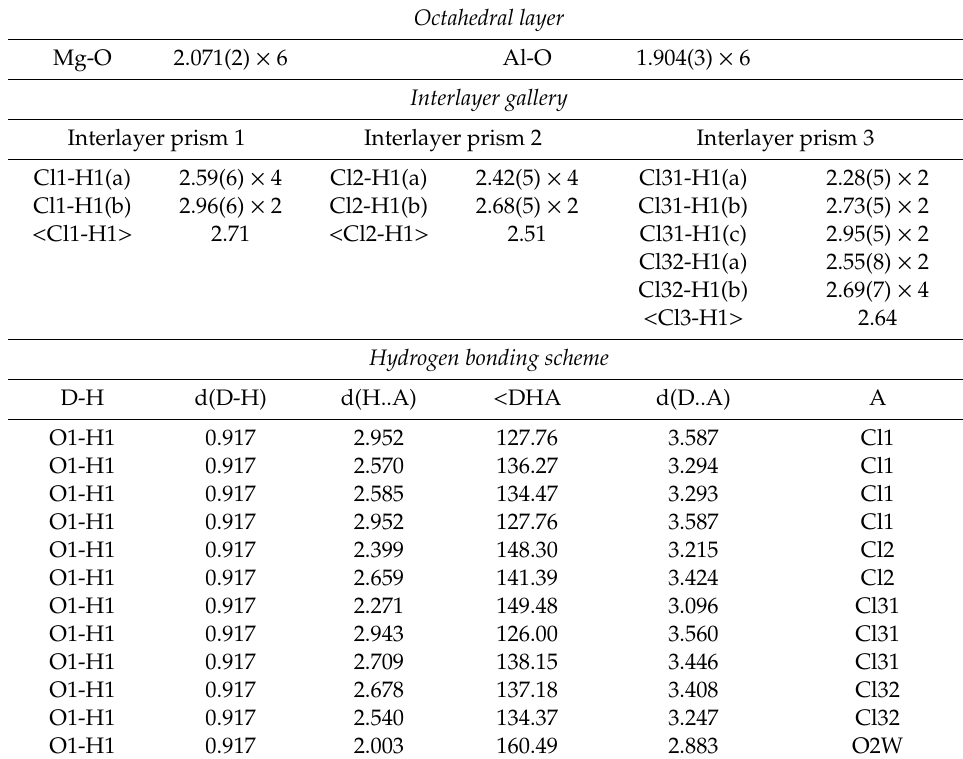
Table 6. Selected bond lengths (Å) and angles ( ◦ ) in the crystal structure of